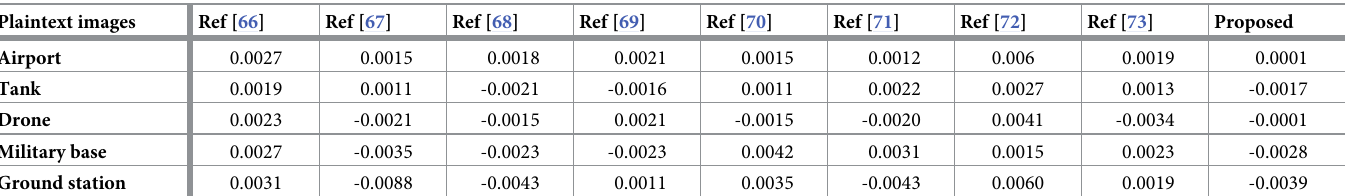
Table 7. Correlation analysis.